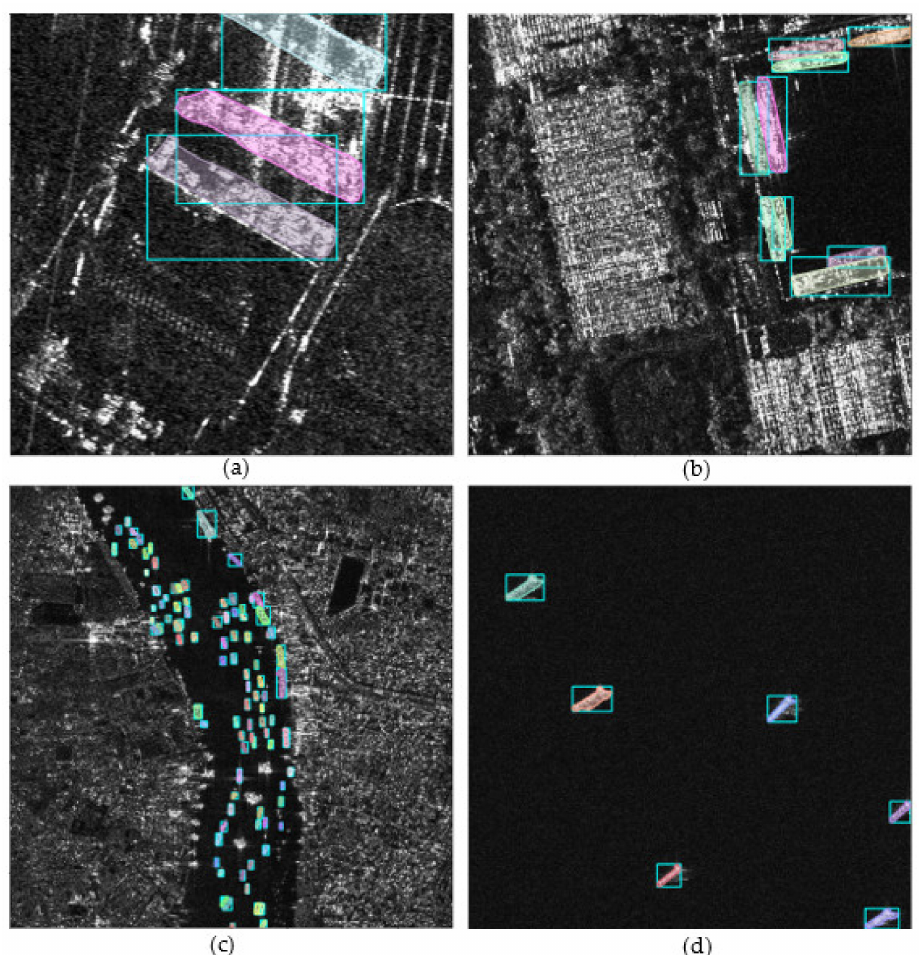
Figure 1. Representative examples of SAR images, showing marine ships of different scales in a complex background. The locations and segmentations of marine ships are outlined by colored rectangles and closed curves. ( a ) A SAR image representing large ships located nearby berthing buildings. ( b ) A SAR image representing middle-scale ships close to berthing buildings. ( c ) A SAR image representing small ships close to berthing buildings. ( d ) A SAR image representing the small ships in the offshore